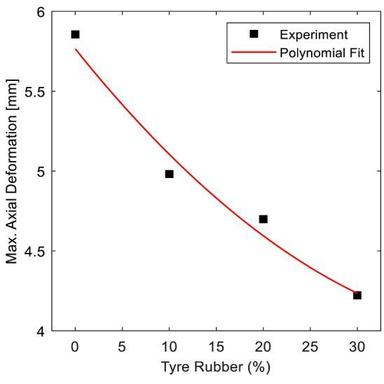
Maximum axial deformation for the different mixes.